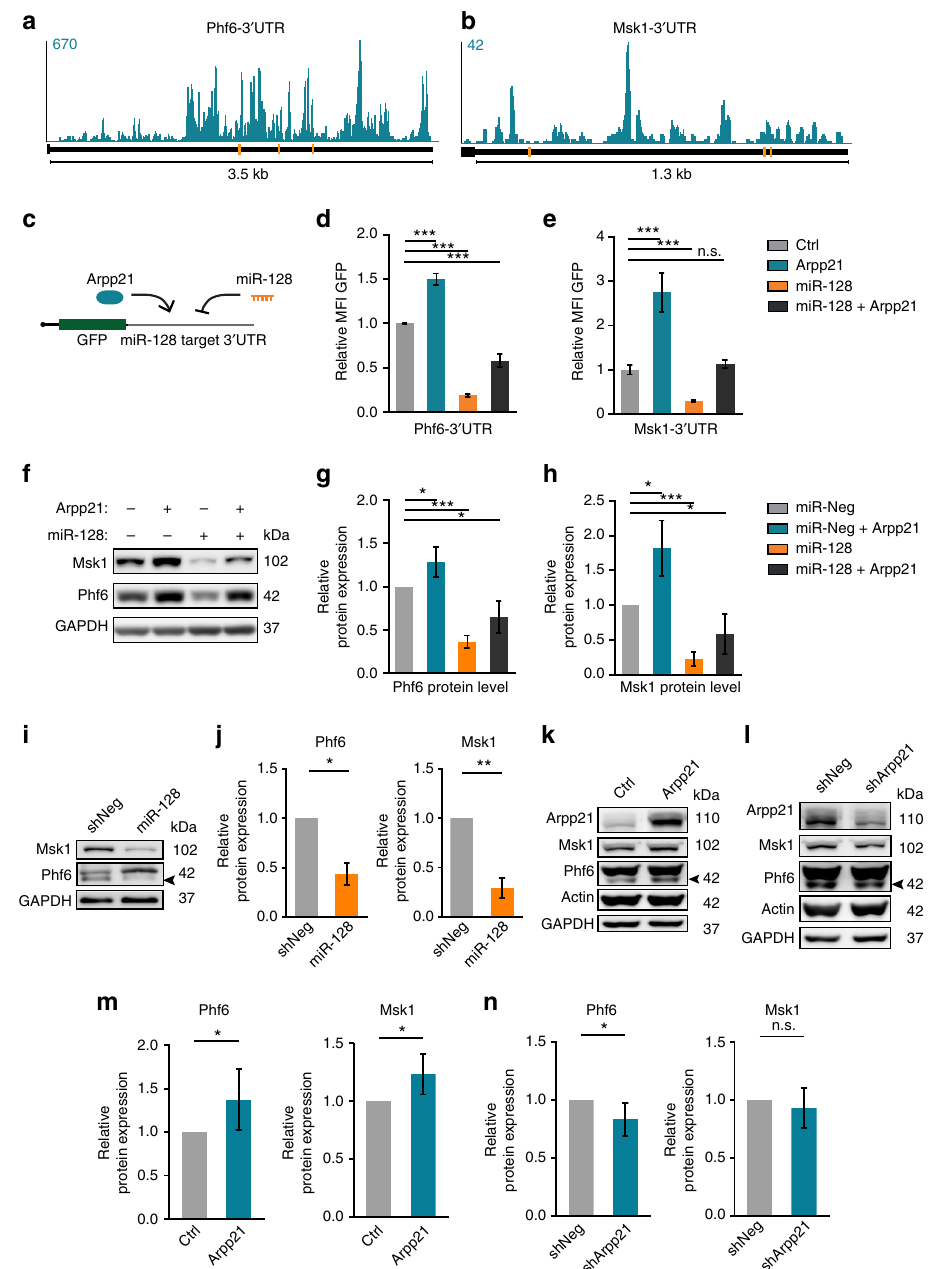
Fig. 6 ARPP21 and miR-128 have antagonistic functions on an overlapping set of target mRNAs. a , b Conserved TargetScan predictions for miR-128-binding sites (orange bars) and ARPP21 iCLIP CL signals (turquoise) at the 3 ′ UTRs of the miR-128 target mRNAs Phf6 and Msk1 . c Schematic of 3 ′ UTR GFP-reporter assay to assess direct effects of miR-128 and ARPP21 on individual transcripts. d , e Phf6 and Msk1 3 ′ UTR reporter fl uorescence upon miR-128 and/or ARPP21 expression normalized to control transfection. miR-128 represses and ARPP21 increases GFP reporter expression; co-transfection leads to intermediate expression. Data expressed as mean ± s.d., *** p < 0.001, Student ’ s t -test, n = 3. f Representative immunoblot analysis of endogenous PHF6 and MSK1 protein levels in 293T cells. ARPP21 transfection leads to increased protein expression of MSK1 and PHF6. miR-128 mimic transfection results in reduced expression of MSK1 and PHF6 protein. Co-transfection leads to intermediate levels. g , h Quanti fi cation of PHF6 and MSK1 protein expression from fi ve independent experiments as in f . * p < 0.05, *** p < 0.001, one-sample t -test against 100%, data represents mean ± s.d. i miR-128 overexpression by lentivirus in primary cortical neurons at DIV7 reduces MSK1 and PHF6 protein expression. The arrowhead marks the speci fi c PHF6 band. j Quanti fi cation of miR-128 overexpression effect on MSK1 and PHF6 protein levels. One-sample t -test against 100%, n = 4 biological replicates, * p < 0.05; ** p < 0.01. Data expressed as mean ± s.d. Protein levels of ARPP21, MSK1, and PHF6 upon ARPP21 overexpression ( k ) and knockdown ( l ) in primary cortical neurons at DIV7. Quanti fi cation of protein expression upon overexpression ( m ) or knockdown ( n ) of ARPP21. One-sample t -test against 100%, n = 6 biological replicates, * p < 0.05. Data expressed as mean ± s.d. Full western blot images are presented in Supplementary Fig.